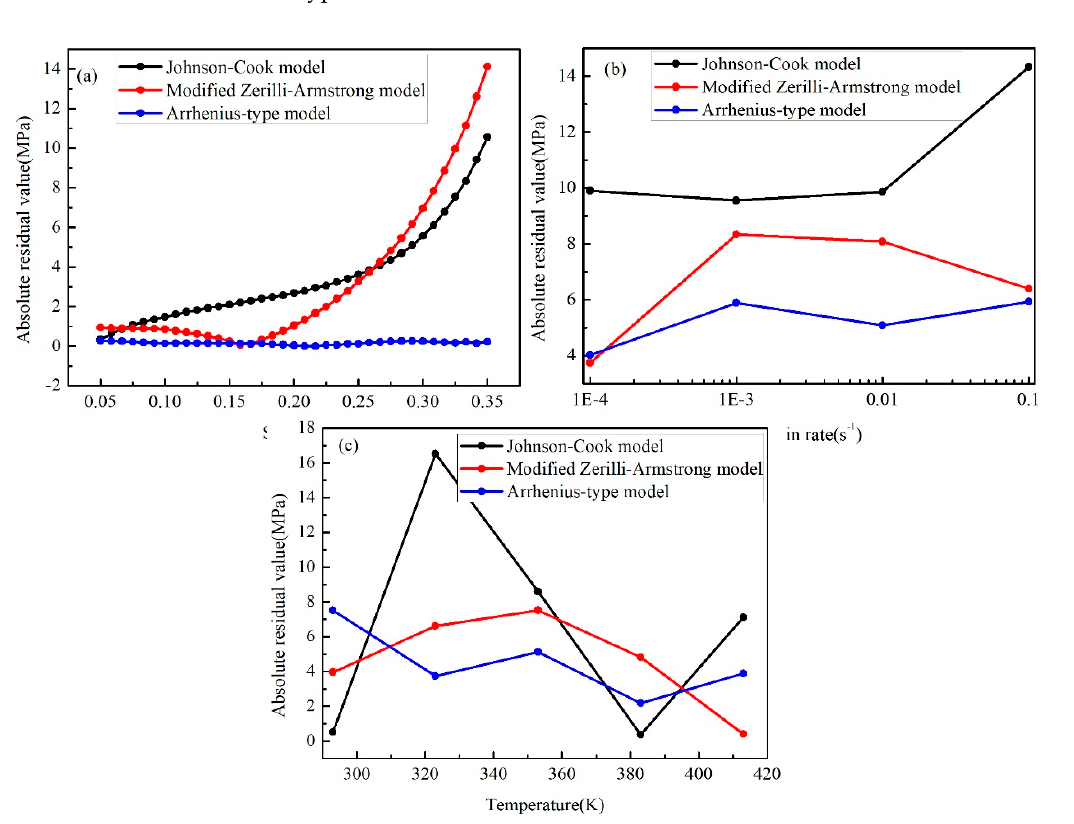
Figure 19. Absolute residual values from three models of ( a ) strain, ( b ) strain rate, and ( c ) temperature.